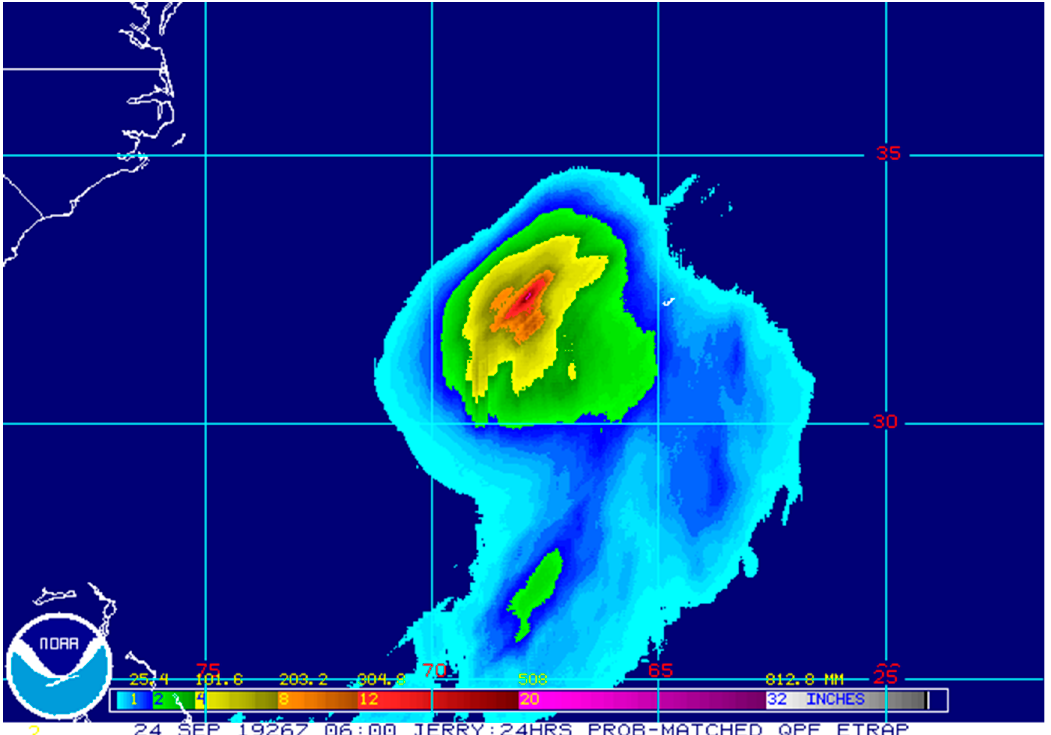
Figure 9. 24hr eTRaP quantitative precipitation forecast (QPF) from 15 independent ensemble members on 24 September 2019 for Tropical Storm Jerry over the Atlantic Ocean. Courtesy of NOAA-NESDIS (https://www.ssd.noaa.gov/PS/TROP/etrap.html?storm=JERRY, last accessed 24 September 2019).